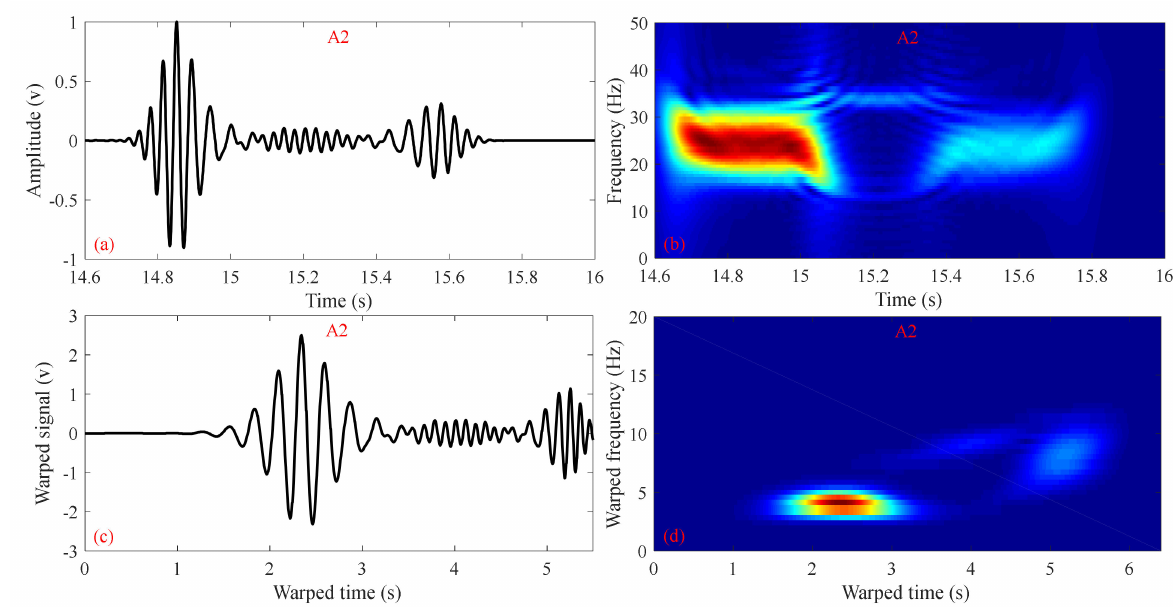
Figure 3. ( a ) The signal by received hydrophone A2, ( b ) the corresponding STFT, ( c ) the warped signal, and ( d ) the corresponding STFT.